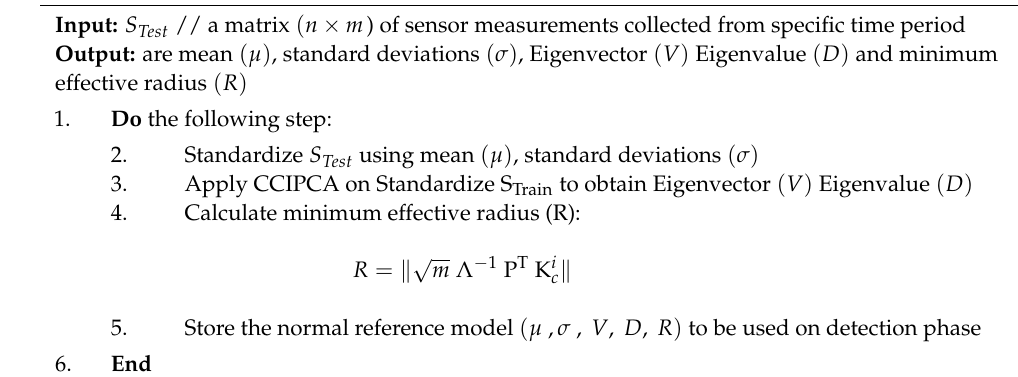
Algorithm 1: Pseudocode algorithm for the training phase of proposed CESVM-DR